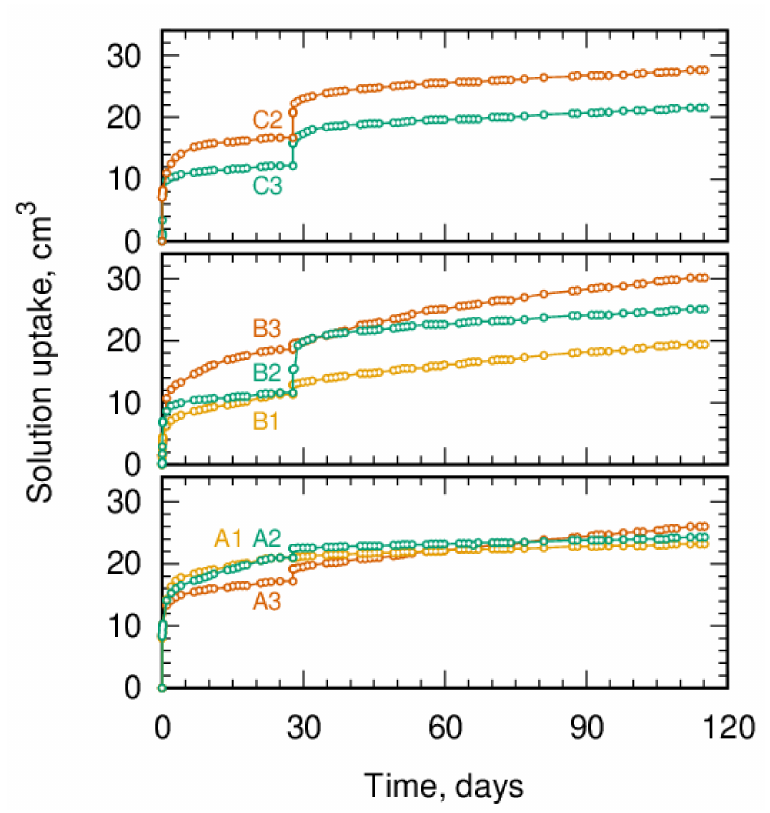
Figure 4. Uptake of SGW by permeameter cells with 10X specimens compacted to dry densities of 1.4 g/cm 3 (A1–A3); 1.6 g/cm 3 (B1–B3); and 1.8 g/cm 3 (C2, C3), upon saturation from burettes connected to inlets at cell bases for 27 days and cell tops